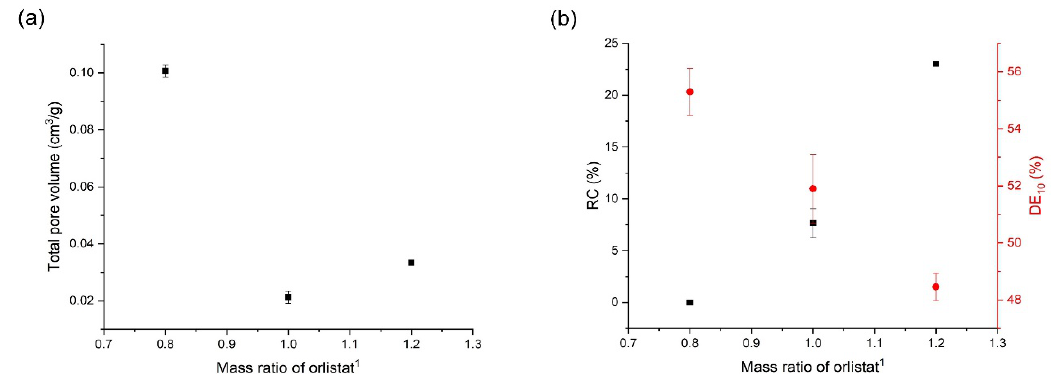
Figure 11. ( a ) Change in total pore volume with change in mass ratio of orlistat and ( b ) the correlation of orlistat mass ratio with relative crystallinity (RC) and DE 10 . 1 The relative mass ratio of orlistat to Neusilin ® UFL2 obtained by dividing the mass of orlistat by the mass of Neusilin ® UFL2.